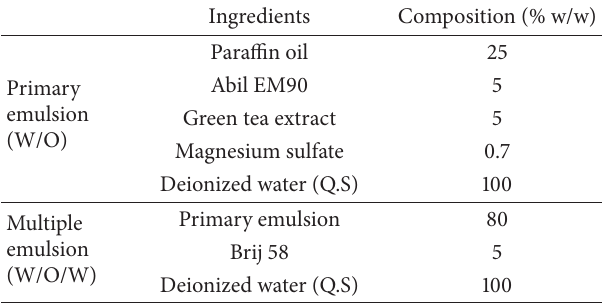
Table 1: Composition of green tea multiple